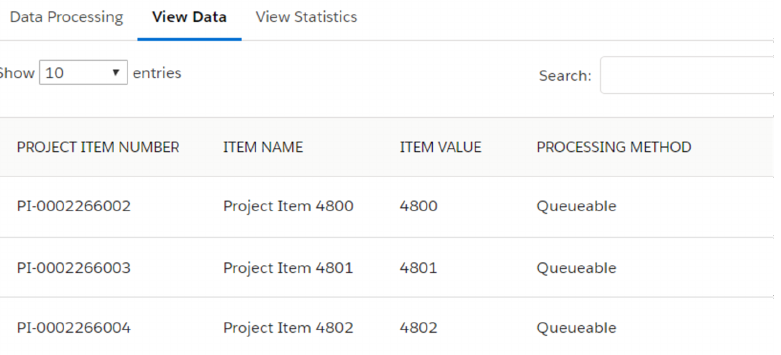
Figure 2. Data Processing tab of Salesforce Data Processor application created to analyze the data processing methods.